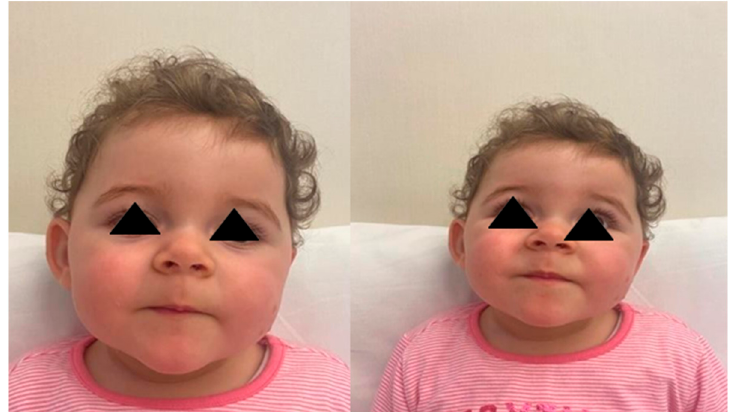
Figure 2. Case 2: Cranial and facial dismorphysm.